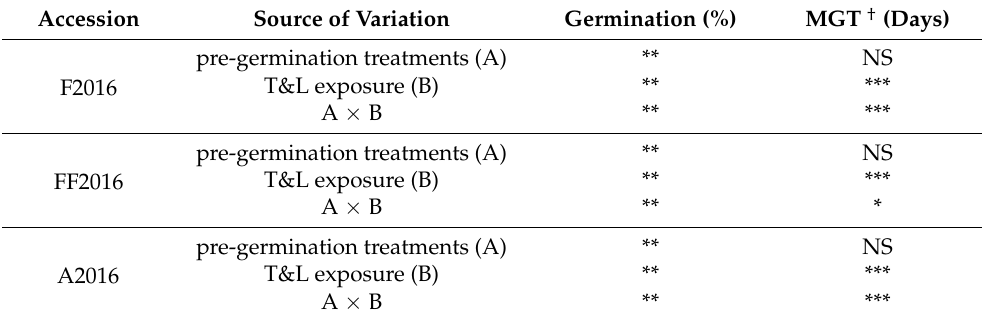
Table 2. Effect of pre-germination treatment (A), temperature/light exposure (B), and their interac- tions (A × B) on germination percentage and mean germination time (days) of P. incarnata seeds, separately for each